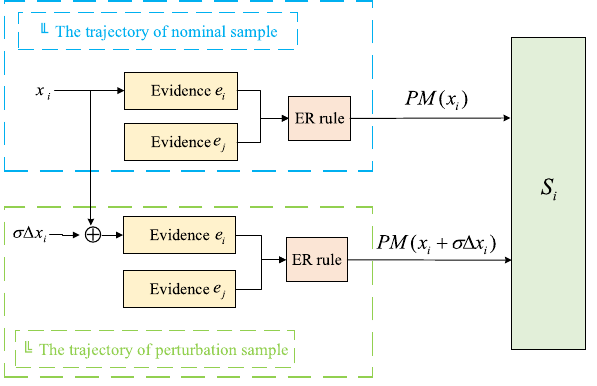
Figure 2. Rolling bearing performance reliability model considering